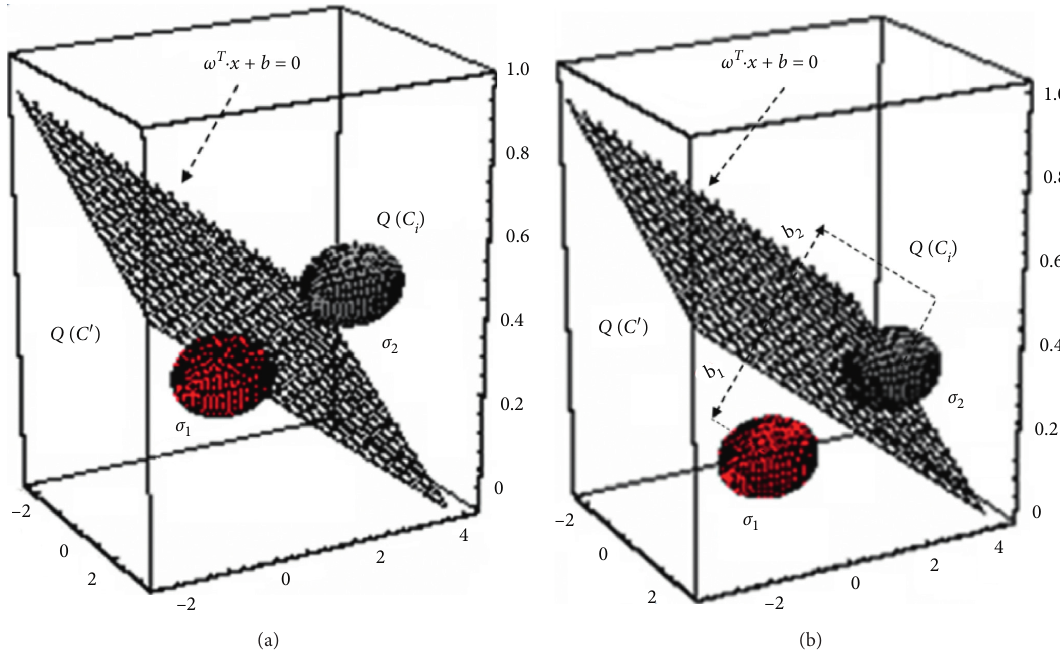
Figure 5: Classification integration process: (a) preliminary classification integration of data blocks; (b) precise classification integration of data blocks.